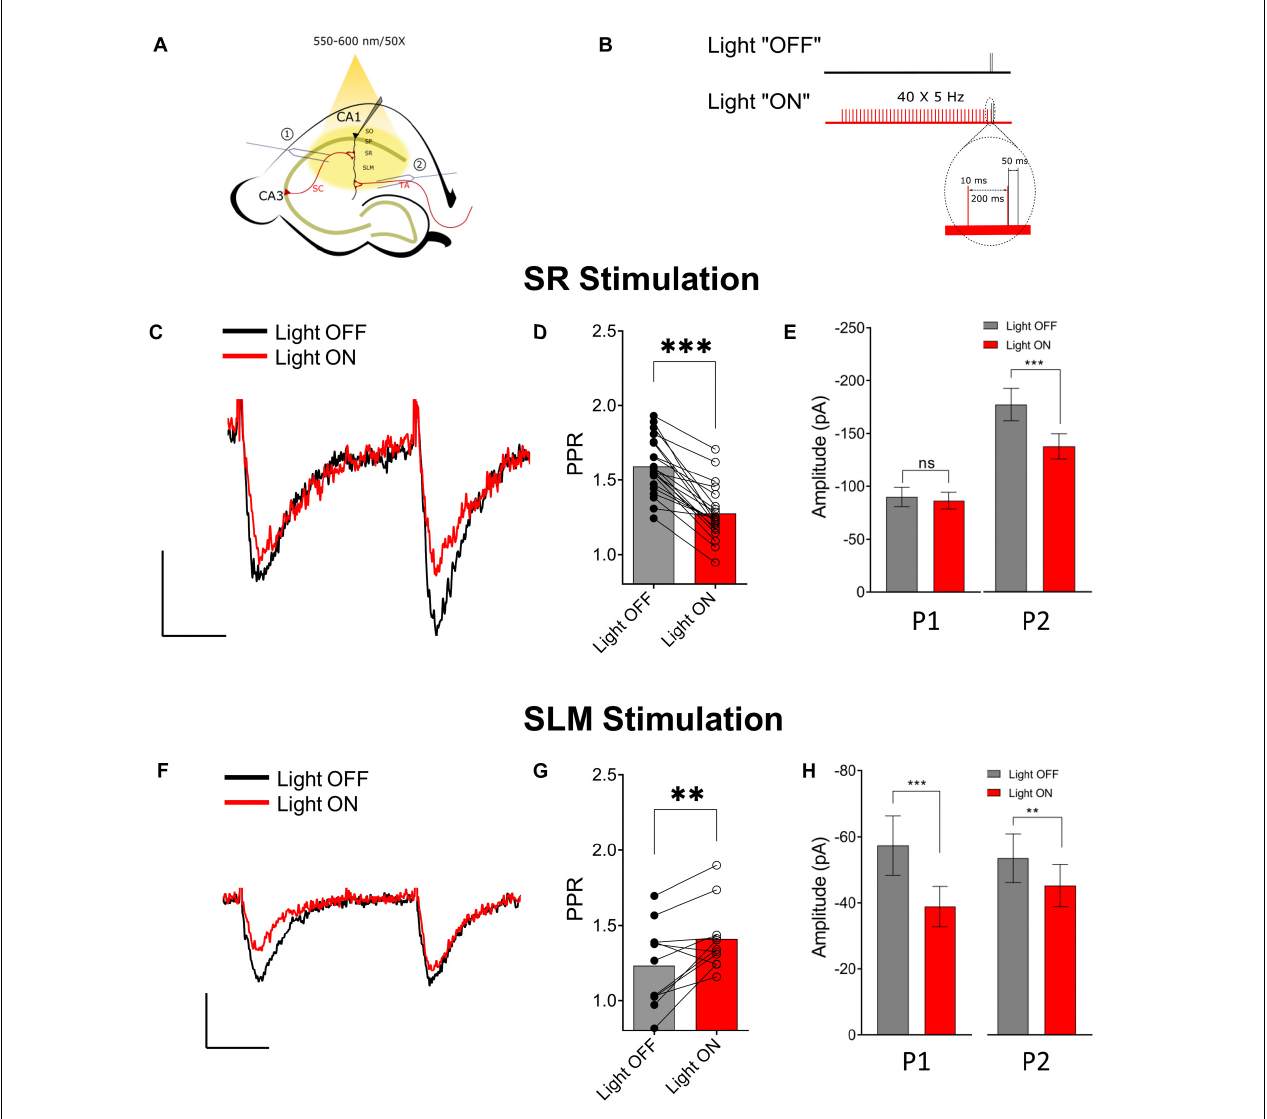
FIGURE 3 | Optogenetically released acetylcholine (ACh) had different effects on Schaffer collateral (SC) and temporoammonic (TA) synaptic inputs. (A) Schematic representation of the experimental configuration: the bipolar stimulating electrode was placed either in (1) the stratum radiatum to stimulate the SC or (2) the stratum lacunosum moleculare to stimulate the TA and RE pathways. (B) Schematic representation of the experimental paradigm; inset shows magnified view of the region marked by dashed line in the “Light ON” condition to show the temporal relationship between the last two light pulses (in red) and the paired electrical pulses (in black). (C) Representative paired-pulse traces from a CA1 pyramidal cell in response to SC stimulation with (red) and without (black) optogenetic stimulation of ACh release. (D) Scatter plot of individual data point overlaid on bar plot shows the effect of ACh release on SC PPR (paired t -test, p < 0.001). (E) Bar plots showing that ACh-release caused significant reduction in the amplitude of the second EPSC (P2; paired t -test; p < 0.0001), but not the first (P1). (F) Representative paired-pulse traces from a CA1 pyramidal cell in response to SLM stimulation with (red) and without (black) optogenetic stimulation of ACh release. (G) Scatter plot of individual data point overlaid on bar plot to show the effect of ACh release on TA PPR (paired t -test, p = 0.0096) (H) Bar plots showing that ACh-release caused significant reduction in the amplitude of both the first (P1) and the second EPSC (P2) (paired t -test; p < 0.05 and p < 0.001, respectively). Scale bars: x = 25 ms; y = 50 pA.